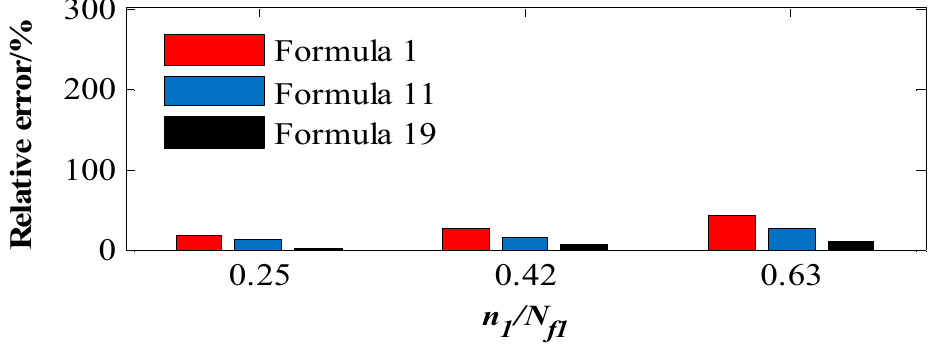
case of high–low loading. This also shows that, from the side, different loading sequences have different effects on the fatigue life. Figure 9. (520–420 MPa) The relative error of each model under different n 1 /N f 1 (18CrNiMo7-6). Table 5. The 45# steel two-stage loading test data and remaining life prediction results of each model.